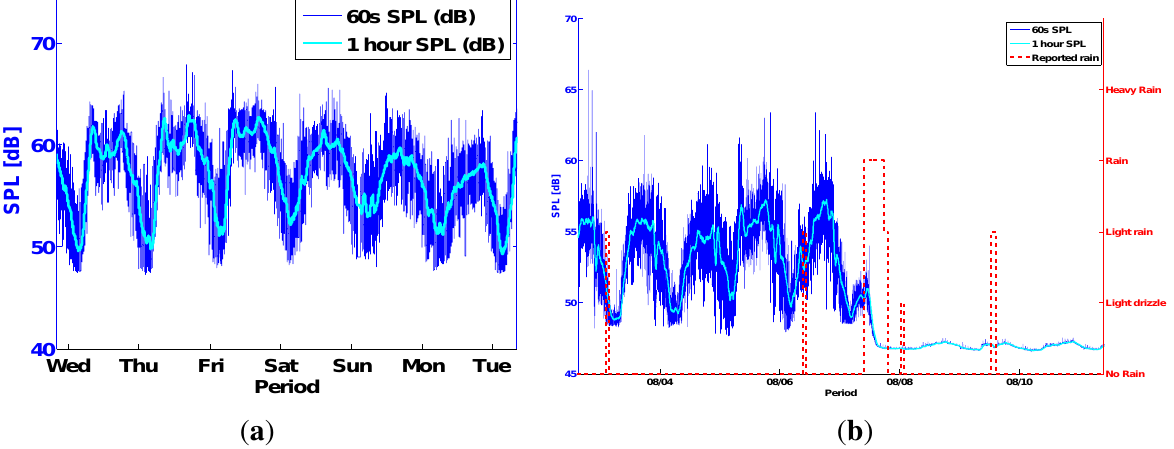
Figure 12. All outdoor test nodes produced a typical urban noise diurnal pattern [19] during healthy conditions ( a ). A sensor failure becomes evident with a visible interruption of the diurnal pattern in the sensor’s output ( b ). Superimposed local weather data suggest that overexposure to rain might be the cause of most sensor malfunctions. ( a ) Diurnal pattern Test Node 2 (MC); ( b ) Sensor failure Test Node 2 and weather